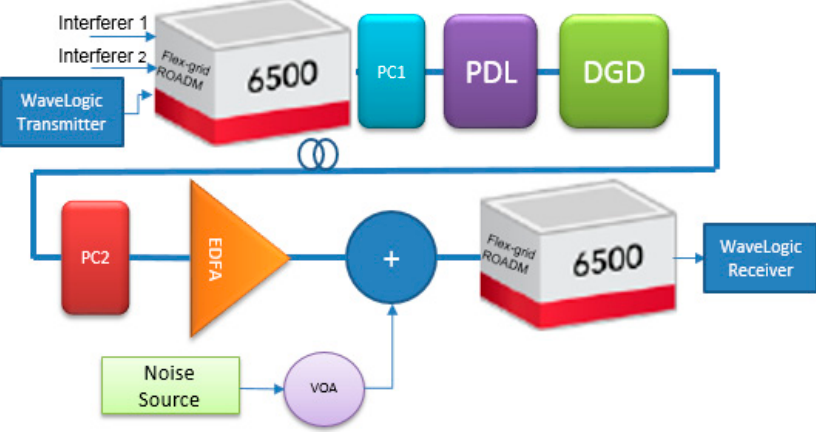
Figure 10. Experimental setup.